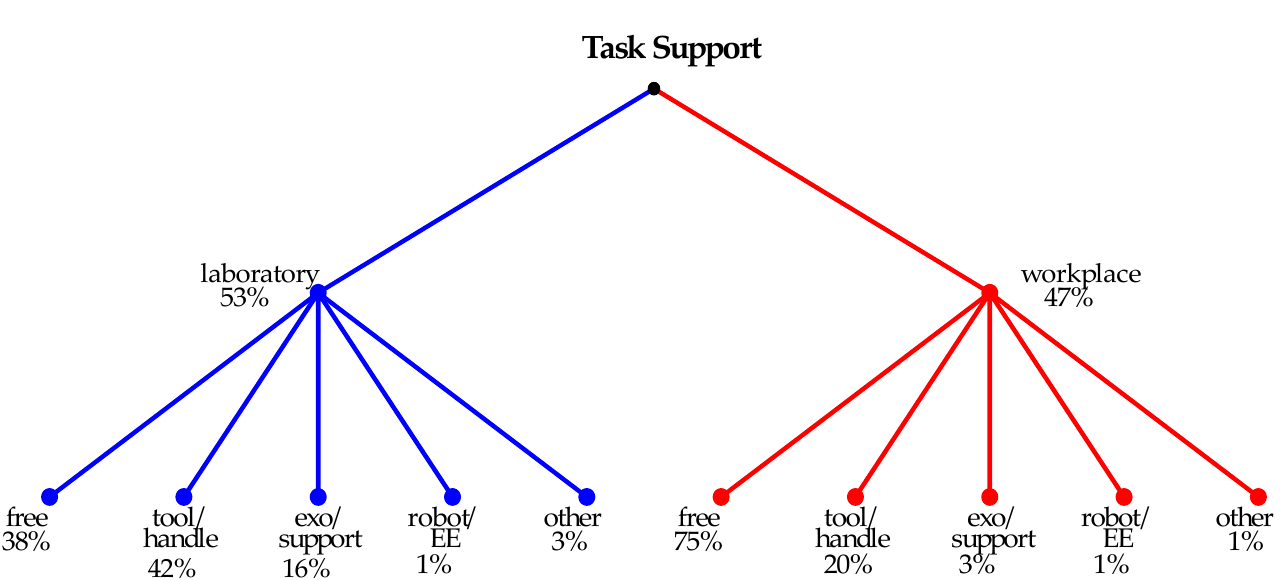
Figure 11. Percentage of the task supports employed for the laboratory setting ( on the left ) and for the workplace setting ( on the right ).